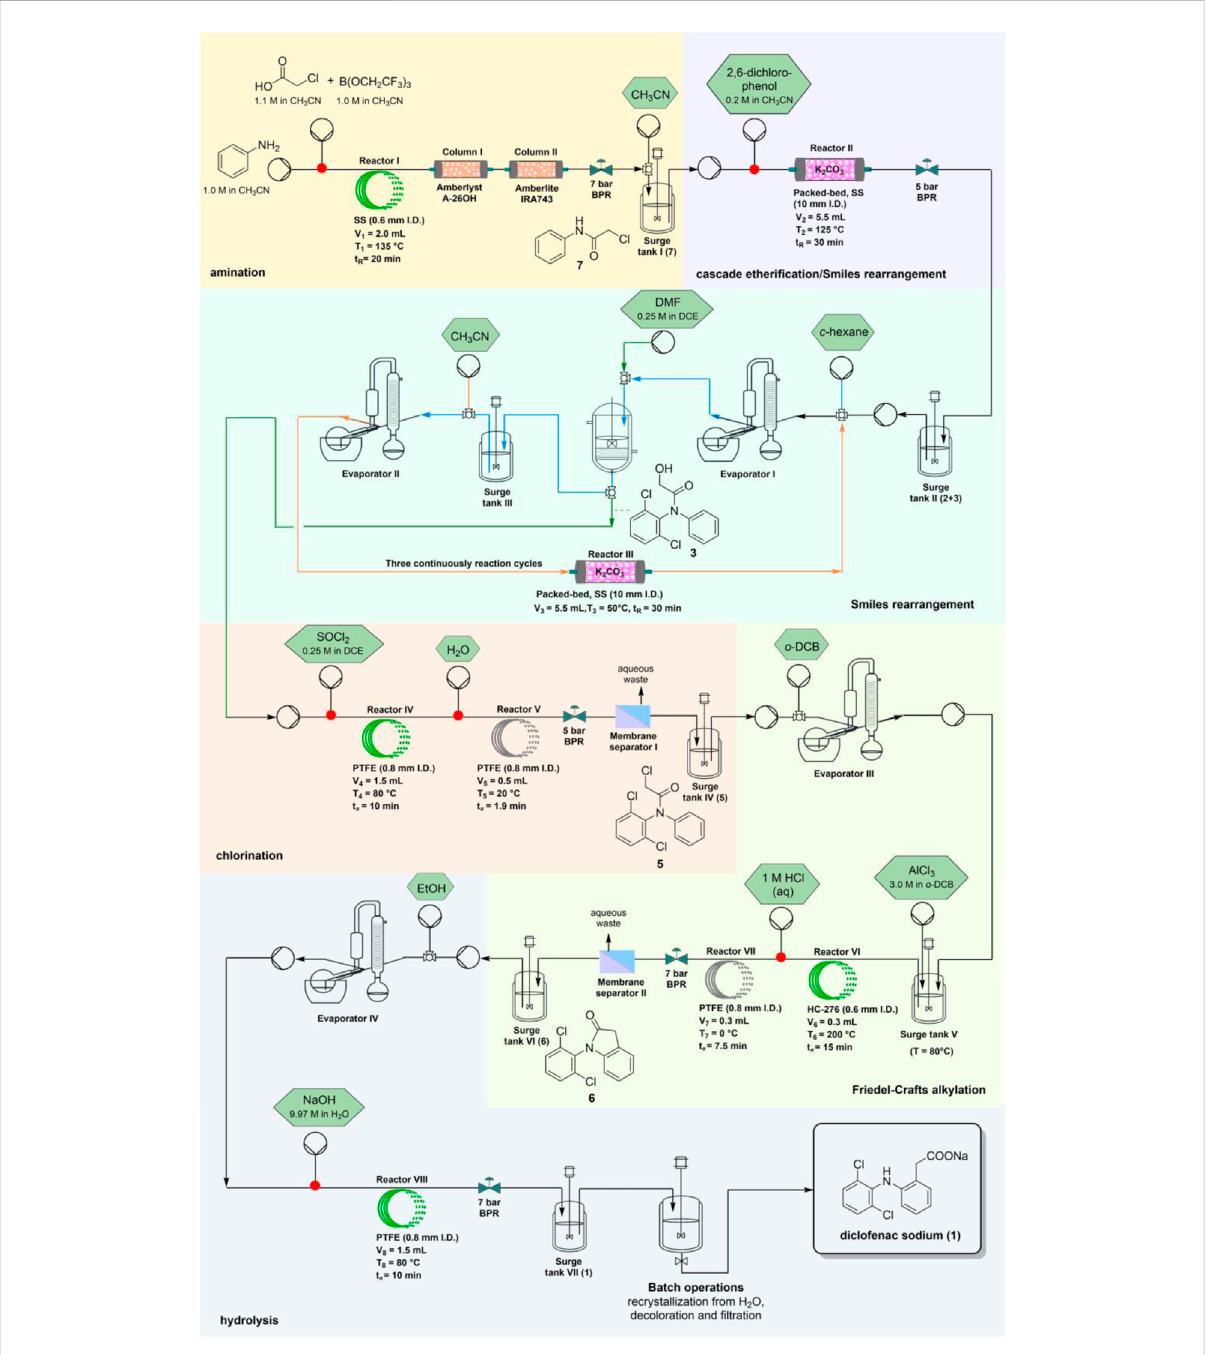
FIGURE 13 Elaborated fl ow synthesis of sodium diclofenac involving sequential amination, chlorination, and hydrolysis protocols. Reprinted with permission from (Wang et al., 2022). Copyright (2022) Wiley-VCH